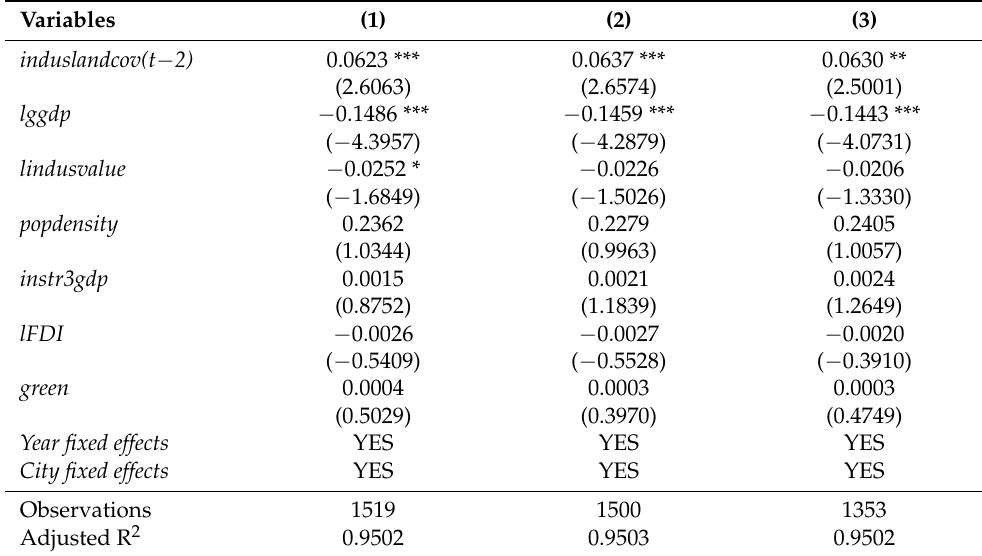
Table 5. Small sample